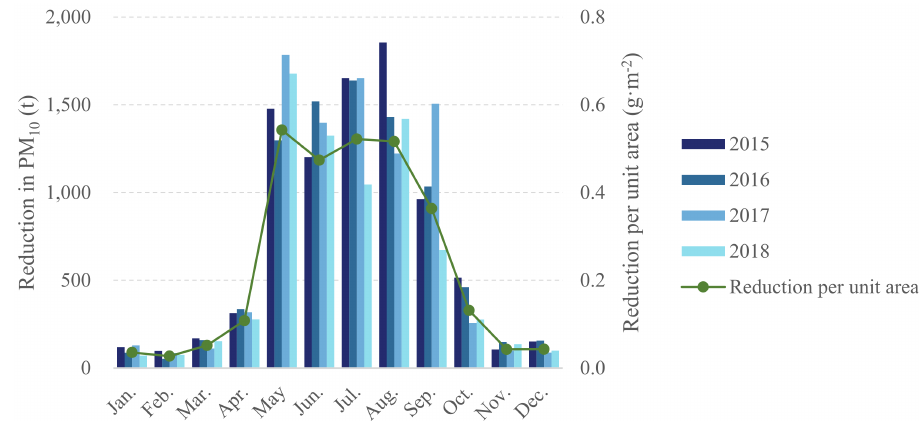
Figure 14. PM 10 removal in each month at the built-up area scale from 2015 to 2018.